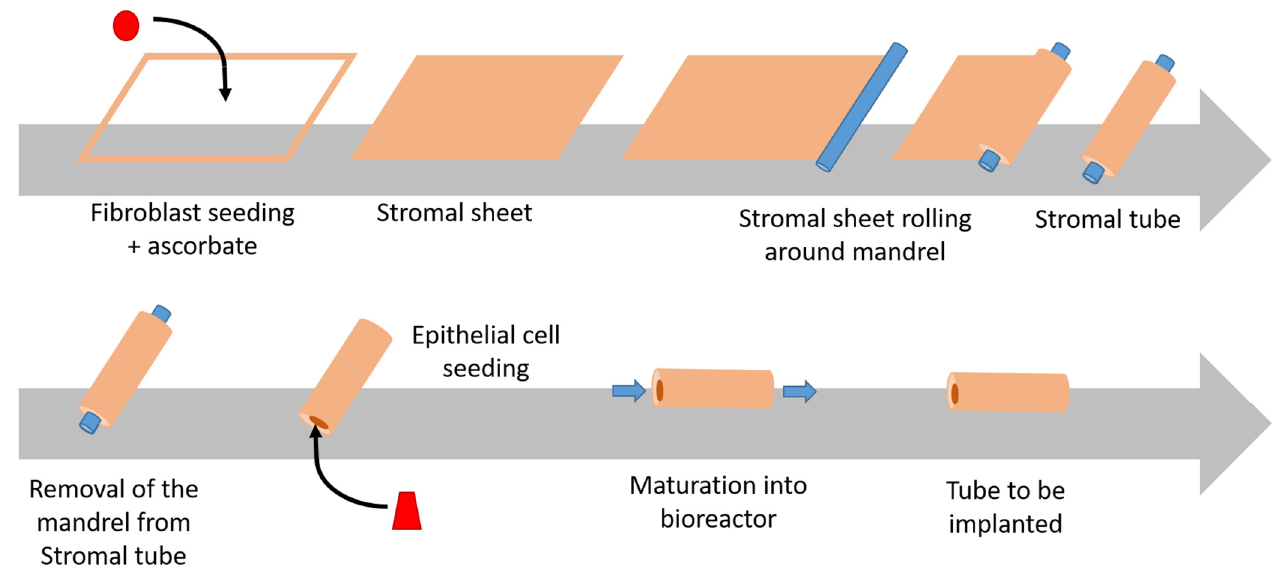
Figure 2. Schema of the production of tubular structure using the self-assembly method. The protocol is described above. It should be noted that ascorbate is maintained during the whole process to allow ECM formation to form the stromal sheet, and also to compensate for ECM degradation due to matrix metalloproteinases (MMP) produced by epithelial cells. The production takes 2 to 3 months to be complete depending on the tissue.